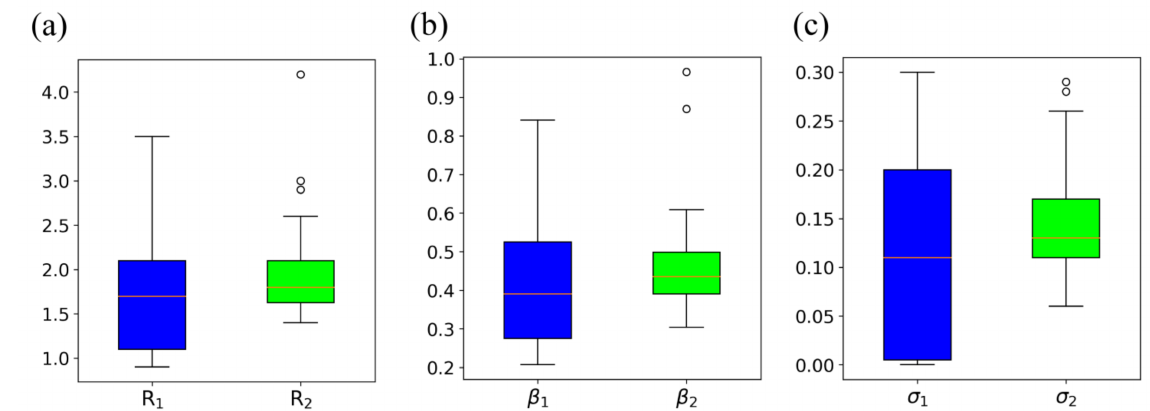
Figure 6. The comparison between the three parameters of the T-SIR model for the first outbreaks (blue) and second outbreaks (green) of the 50 US states. ( a ) Reproduction numbers R . ( b ) Transmission rates β . ( c ) Intervention parameters σ